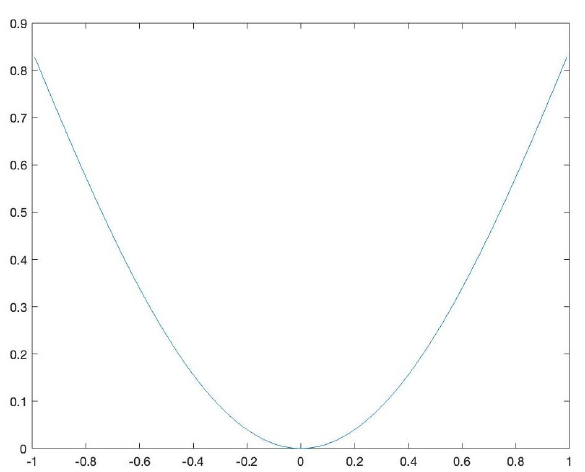
Figure 3. Example 5: graphic of k ( x ) =